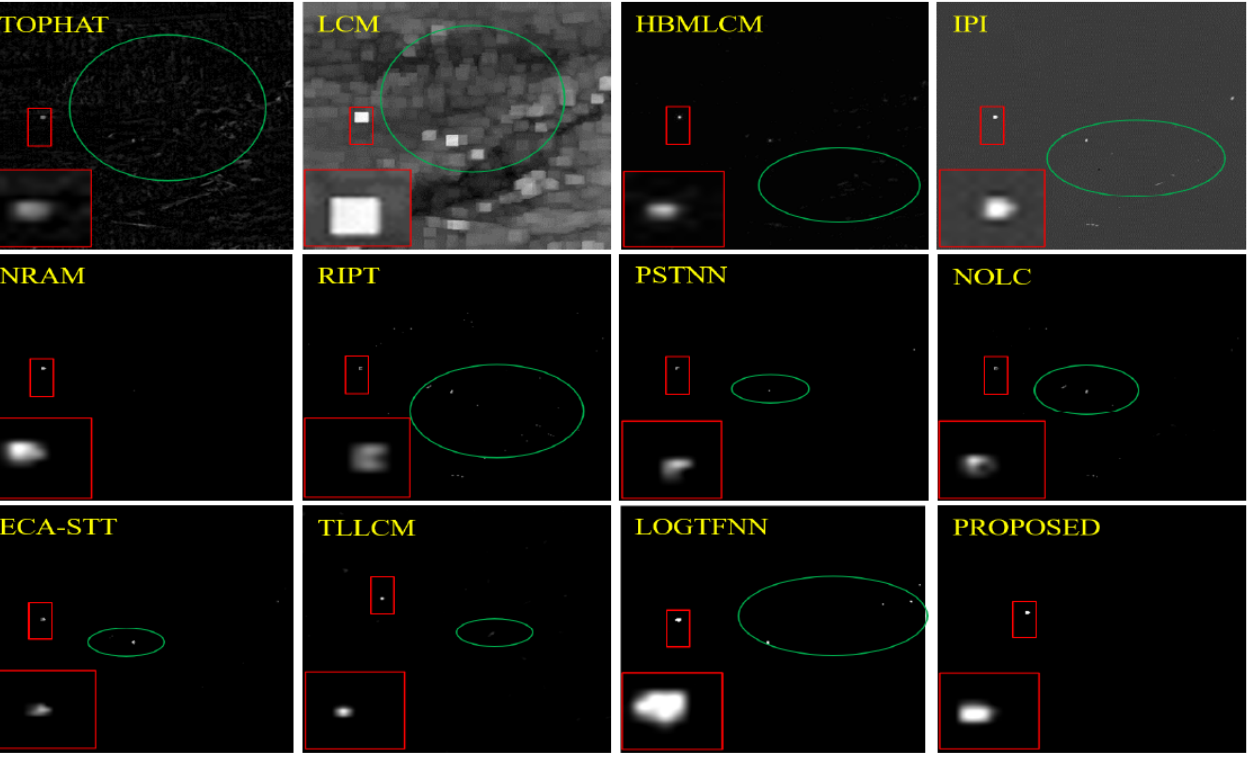
Figure 24. The detection results of data 3.